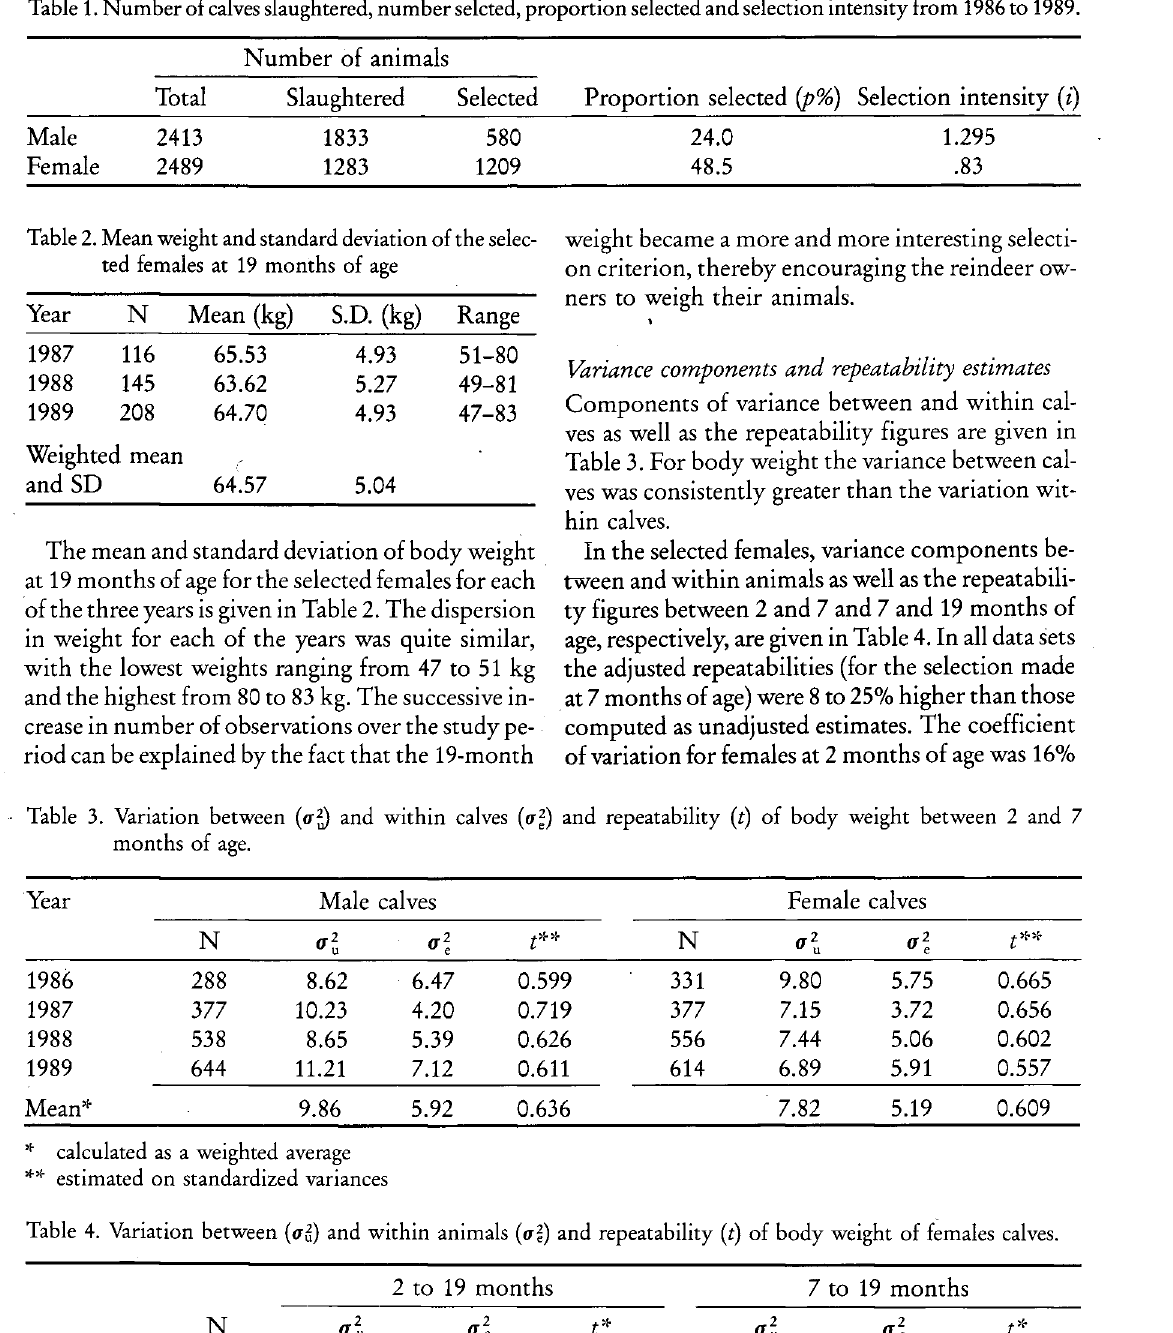
Table 4. Variation between (o£) and within animals (aI) and repeatability (t) of body weight of females calves. 2 to 19 months